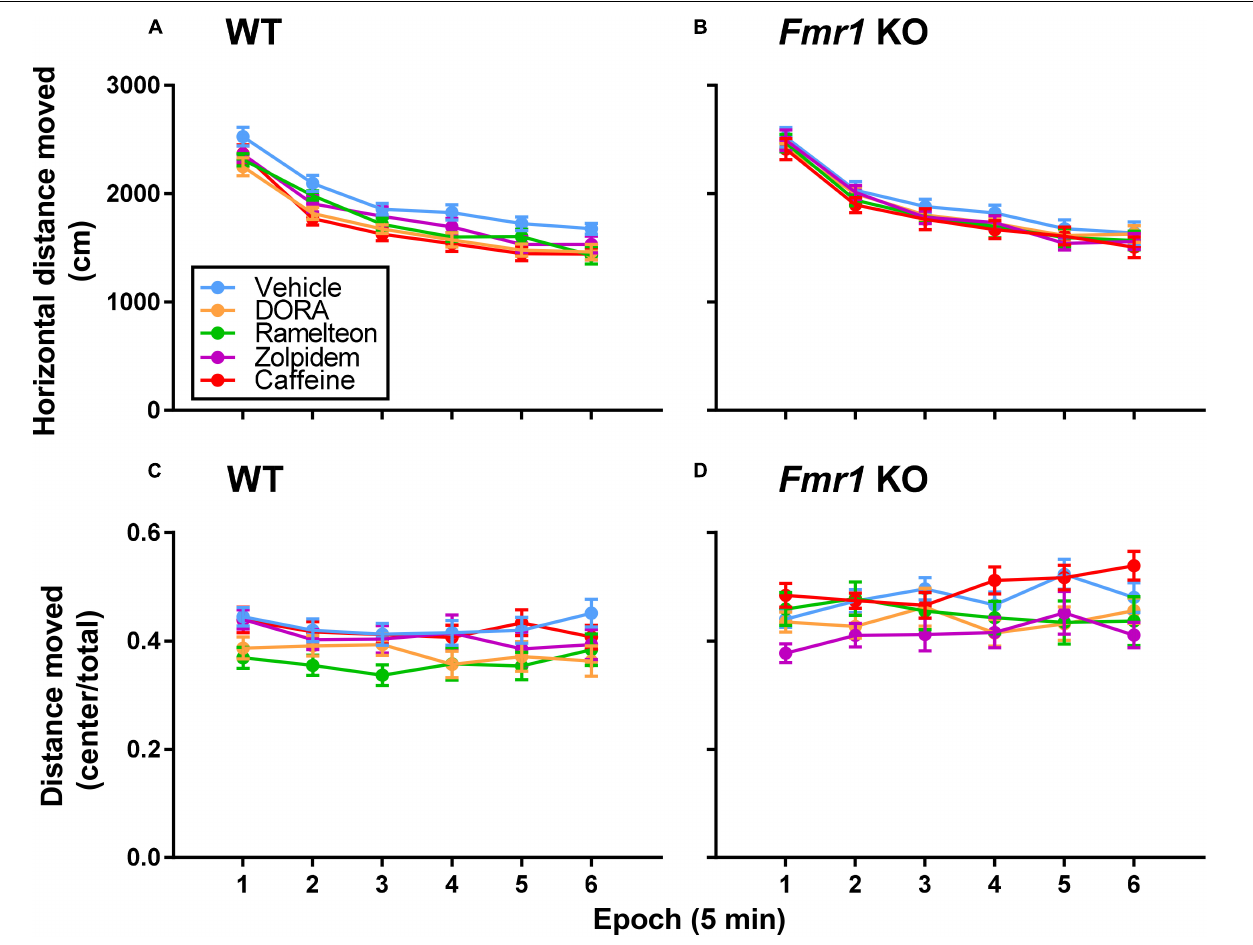
FIGURE 3 | (A,B) Novelty-induced activity in an open field. Each point represents the mean ± SEM for the following number of animals: (15 WT Vehicle, 18 WT DORA-22, 14 WT ramelteon, 15 WT zolpidem, 15 WT caffeine, 16 Fmr1 KO Vehicle, 15 Fmr1 KO DORA-22, 12 Fmr1 KO ramelteon, 14 Fmr1 KO zolpidem, and 15 Fmr1 KO caffeine). In both the hypnotics and caffeine analyses main effects of treatment (hypnotics, p ≤ 0.027; caffeine, p = 0.005) and epoch (both hypnotic and caffeine, p < 0.001) were statistically significant. All mice, regardless of genotype or treatment, showed habituation to the novel environment over time. Additionally, regardless of epoch or genotype, DORA-22 ( p = 0.029) and caffeine ( p = 0.005) reduced activity compared to vehicle-treated mice. (C,D) Novelty-induced anxiety-like behavior in an open field. For the hypnotics analysis, the genotype x epoch interaction was statistically significant ( p = 0.040). Regardless of treatment, Fmr1 KO mice traveled significantly more relative distance in the center than WT mice in Epochs 2–6 ( p ≤ 0.020) indicating decreased anxiety-like behavior compared to WT mice. For the caffeine analysis, the main effect of genotype was statistically significant ( p < 0.001) also indicating decreased anxiety-like behavior in Fmr1 KO mice compared to WT mice regardless of treatment. For the hypnotics analysis, the main effect of treatment was also statistically significant ( p = 0.033). Regardless of genotype or epoch, DORA-22-treated mice ( p = 0.080) and Ramelteon-treated mice ( p = 0.089) tended toward decreased relative distance traveled in the center compared to vehicle, suggesting increased anxiety-like